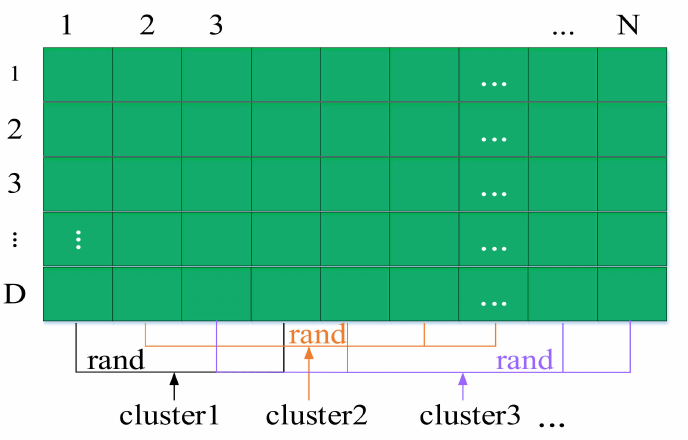
Figure 2. Schematic diagram of random